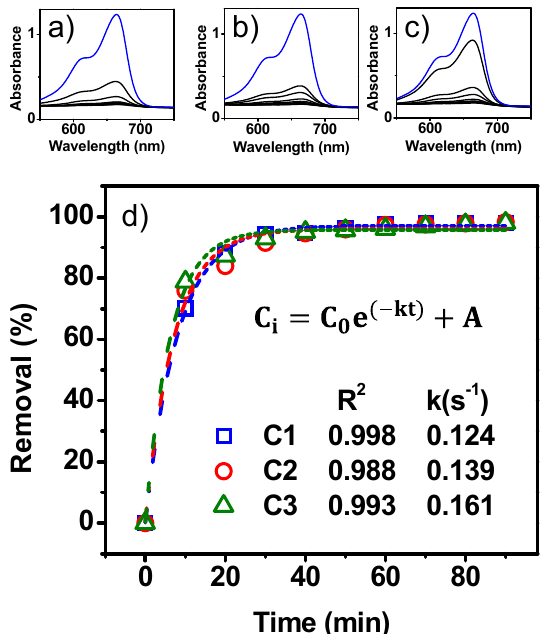
Figure 8. Evaluation of the number of filter layers in methylene blue removal: ( a , b , c ) UV-Vis spectra for C1 = 2, C2 = 3 and C3 = 4 layers, respectively. ( d ) Removal curves for each condition. J. Mar. Sci. Eng. 2020 , 8 , x FOR PEER REVIEW